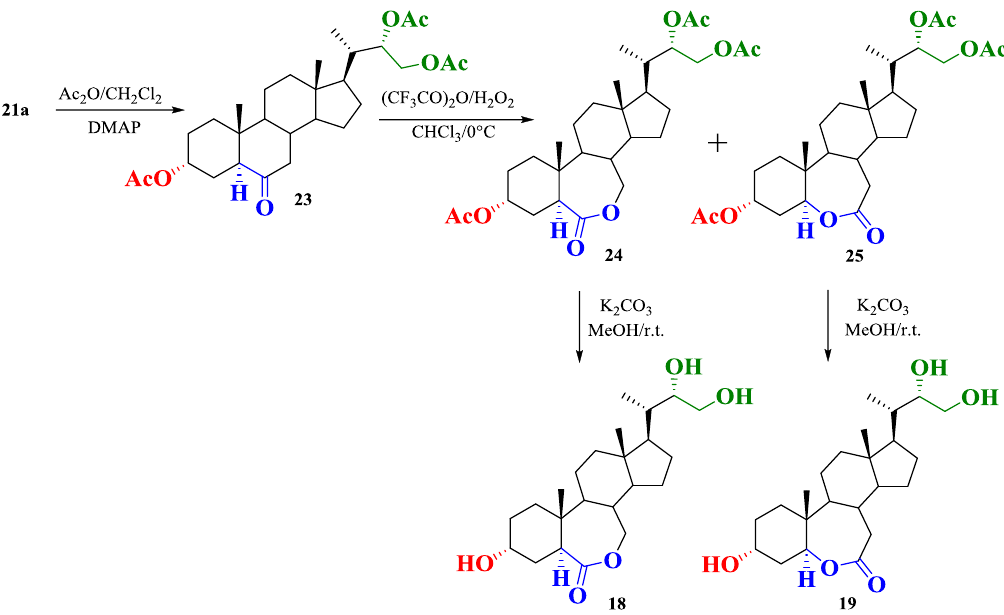
Figure 4. ORTEP diagram of derivative 22 showing full atom-numbering scheme. Thermal ellipsoids are drawn at the 50% probability level.